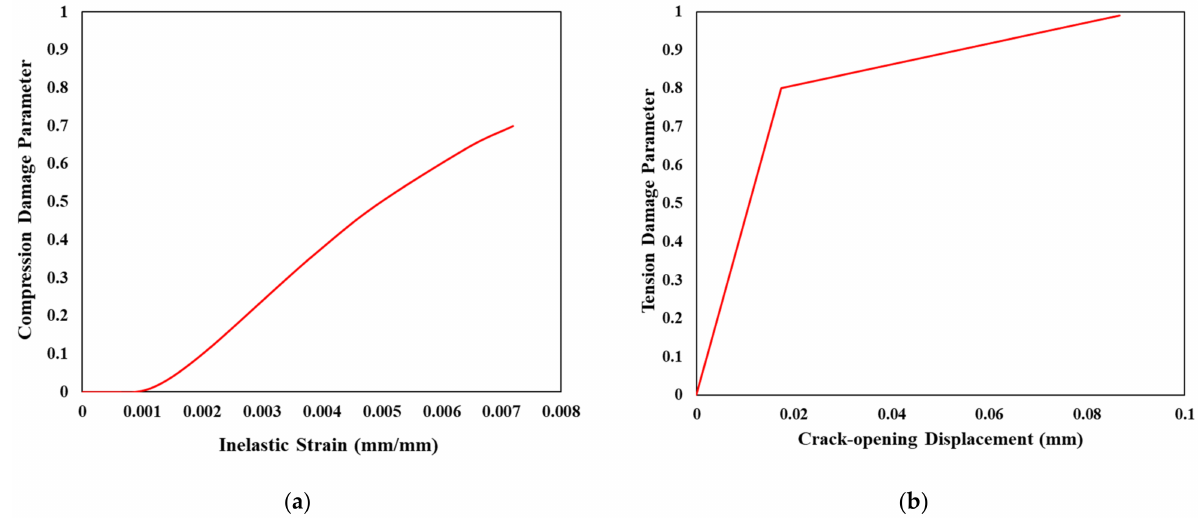
Figure 6. Damage behavior of concrete in ( a ) compression and ( b ) tension